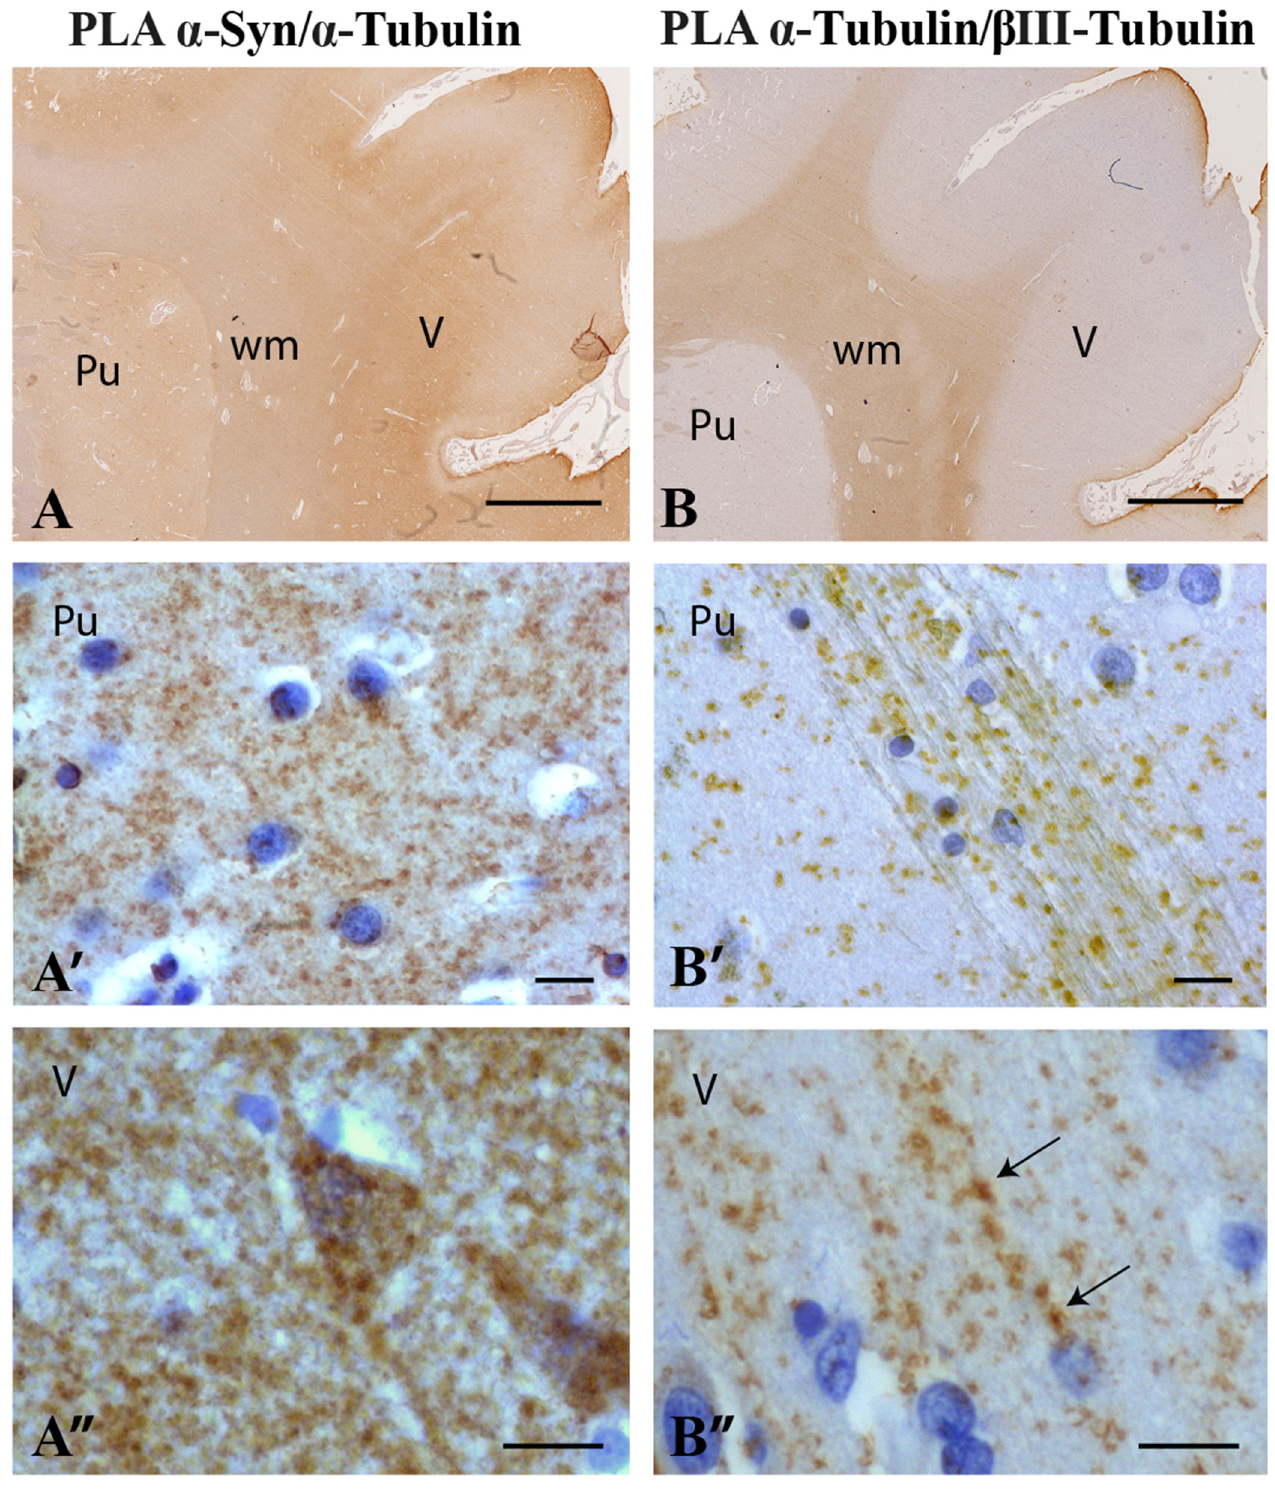
Figure 5. Brightfield PLA procedure for α -synuclein/ α -tubulin PLA in human corpus striatum and cerebral cortex. ( A ): Low magnification image of PLA staining (brown) for α -synuclein/ α -tubulin PLA in human brain corpus striatum and cerebral cortex ( n = 4 subjects). ( A’ , A” ): High magnification photomicrographs of putamen (Pu, ( A’ )) and cerebral cortex layer V (V, ( A” )). ( B ): Low magnification image of PLA staining (brown) for α -tubulin/ β III-tubulin PLA in human corpus striatum and cerebral cortex used as a positive control. ( B’ , B” ): High magnification photomicrographs of putamen ( B’ ) and cerebral cortex layer V ( B” ). Arrows indicate signal in the apical dendrites of pyramidal neurons. Nuclei are counterstained with hematoxylin (violet). wm: white matter. Scale bars: 2.5 mm ( A , B ), 20 µ m ( A’ – B”